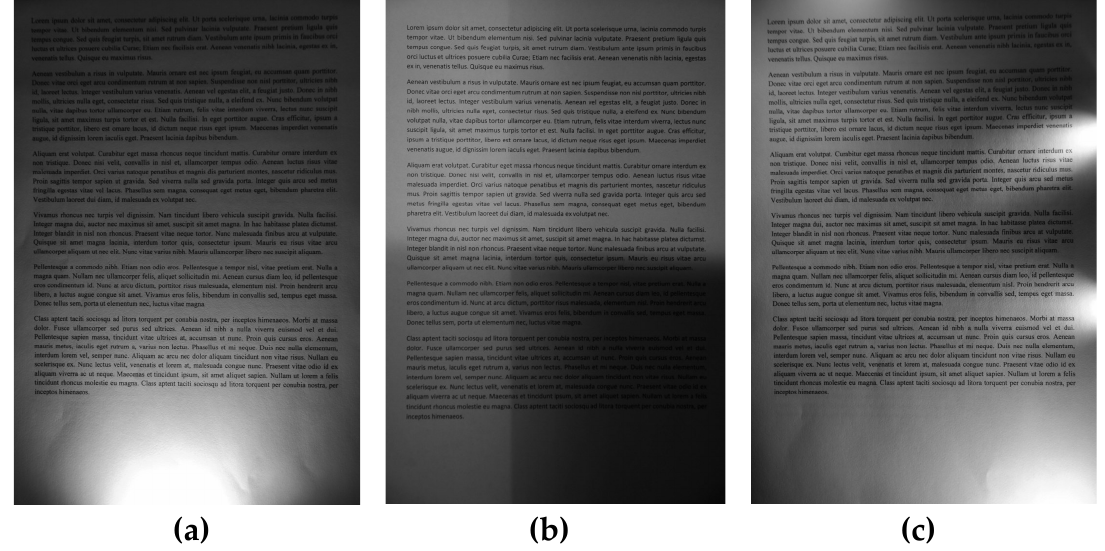
Figure 1. Three sample unevenly illuminated images from the dataset used in experiments. ( a ) with strongly illuminated bottom part; ( b ) with regular shadows; ( c ) with strongly illuminated right